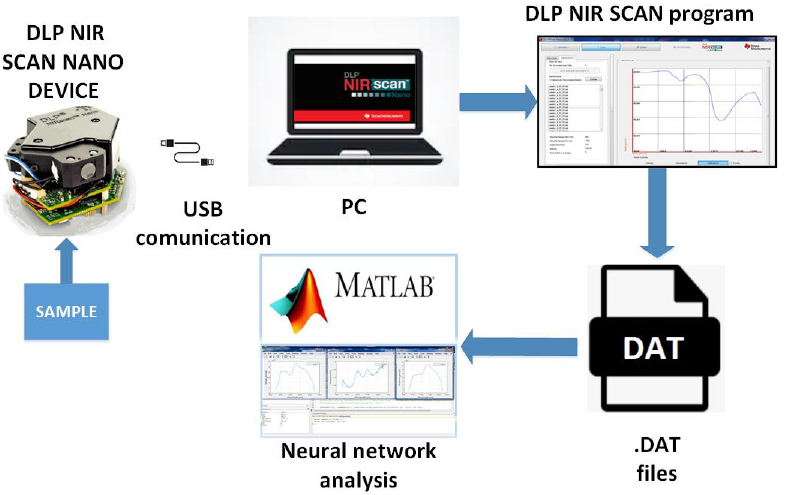
Figure 3. Visualization of the measurement data flow between components of the measurement stand.Hardware: DLP Nirscan EVM and PC; Software: DLP NIRscan Nano GUI and Matlab.